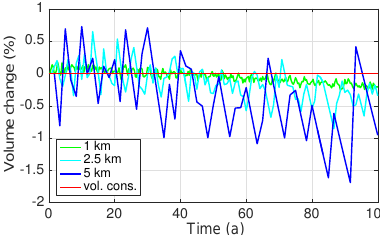
Figure A3. Evolution of the relative ice volume change for different element sizes. The red line shows volume